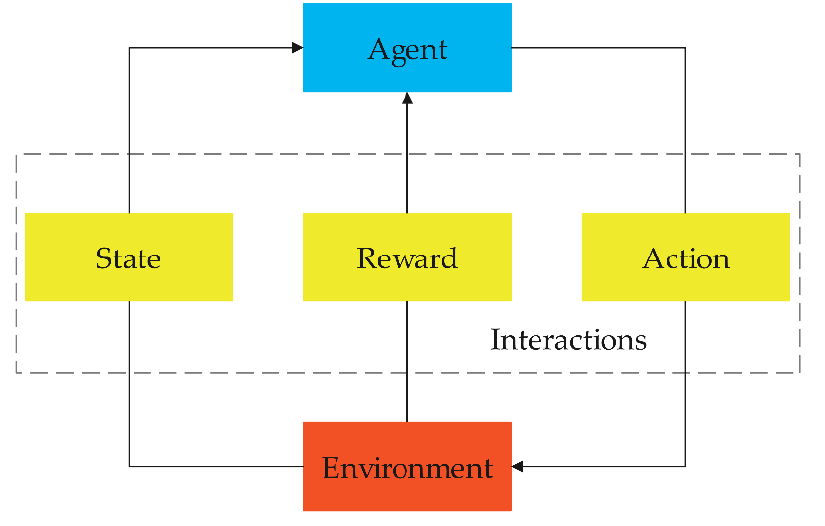
Figure 1. Basic framework of HDRLM3D.